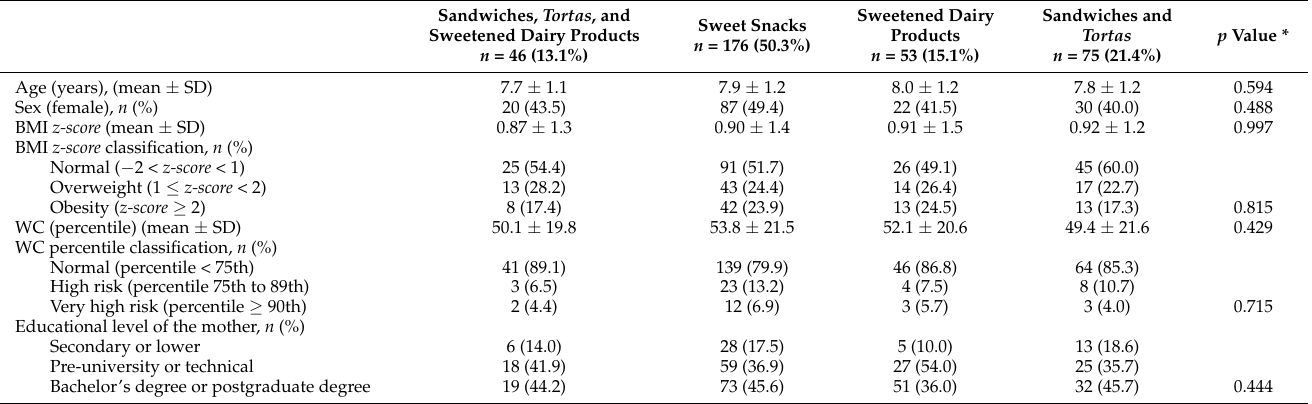
Table 3. Socioeconomic, anthropometric, and clinical characteristics according to dietary